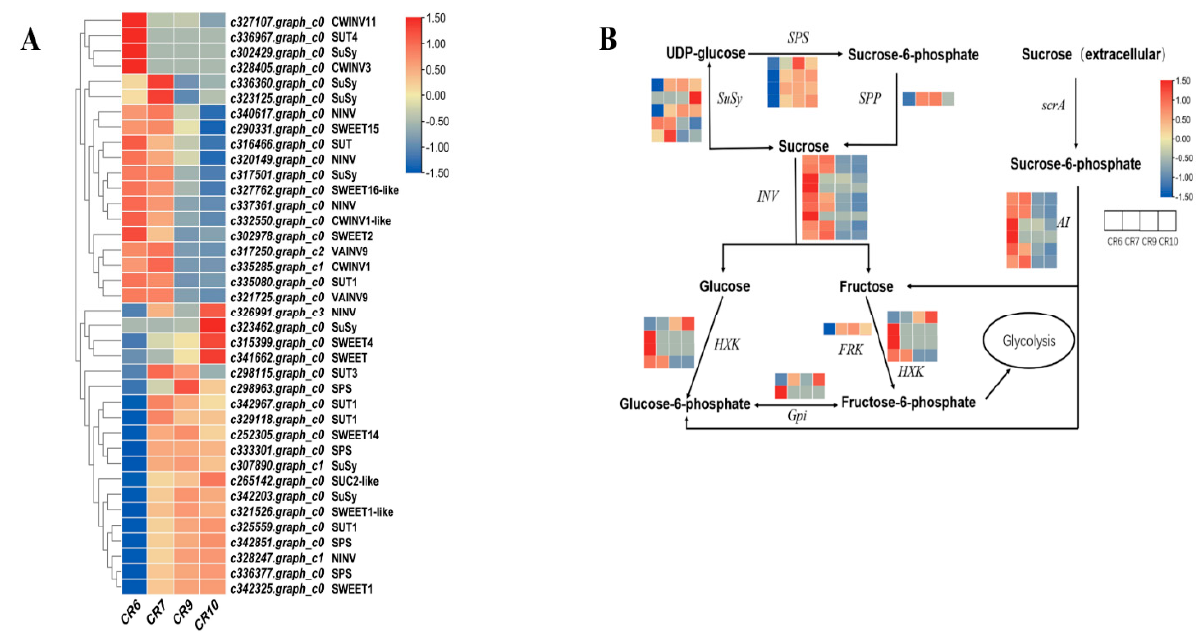
Figure 7. Heat map of DEGs related to sucrose transporters and sucrose metabolic enzymes. ( A ) The heat map was observed by TBtools based on RNA − seq FPKM. The right column shows the corresponding gene IDs and gene names, respectively. The color bar represents the expression level of each gene. ( B ) A simplified sucrose biosynthesis and inversion pathway. Heatmap of columns and rows represents samples and genes, respectively. SPS: sucrose phosphate synthase; SuSy: sucrose synthase; SPP: sucrose phosphatase; INV: invertase; HXK: hexokinase; FRK: fructokinase; Gpi: glucose − 6 − phosphate isomerase; scrA: sucrose − specific phosphotransferase; AI: acid invertase.